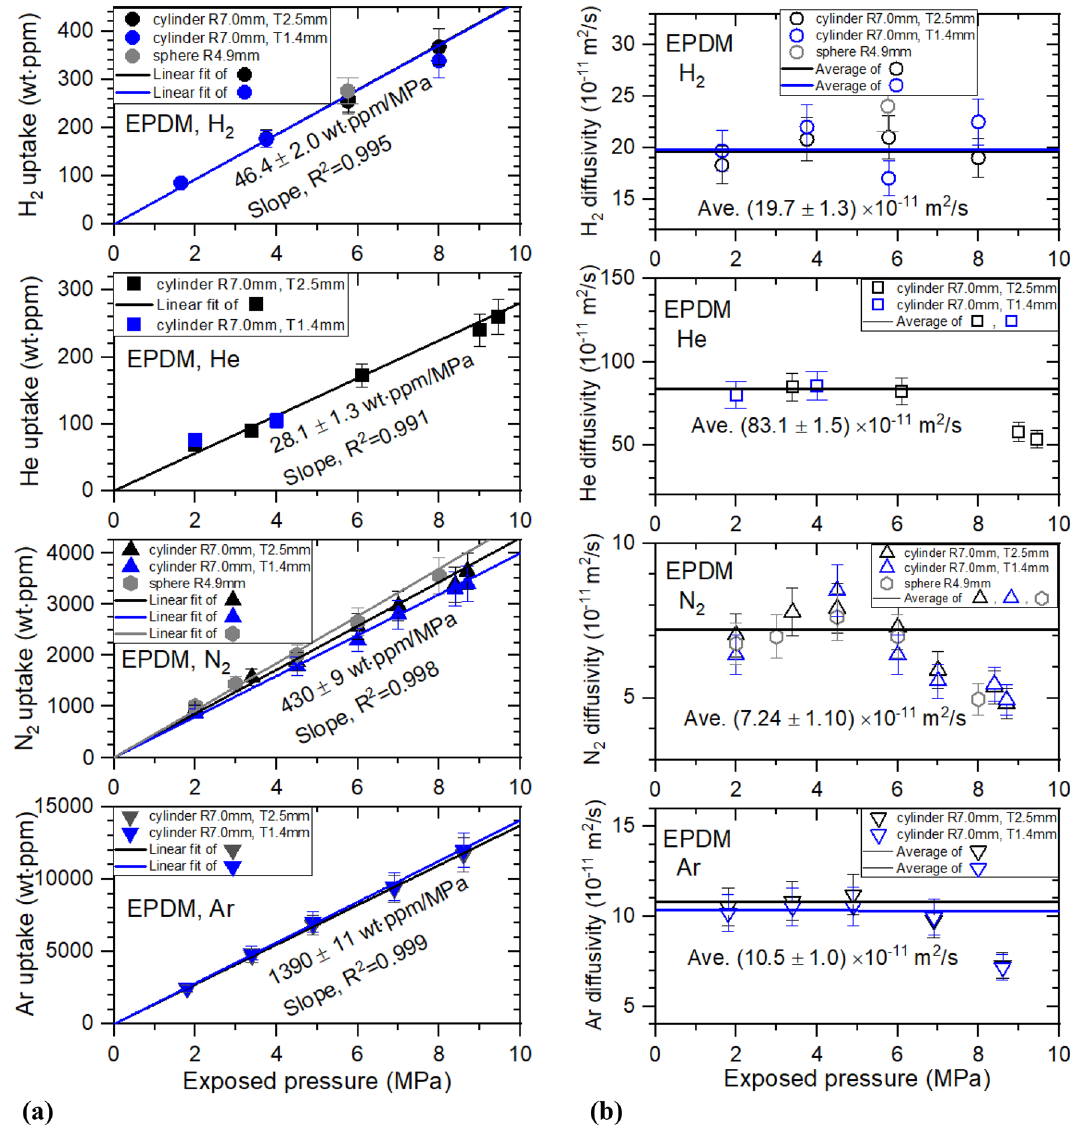
Figure 7. ( a ) Gas uptake ( C ) and ( b ) diffusivity ( D ) versus exposed pressure for four gases in cylindrical ∞ EPDM with different thicknesses and spherical EPDM. R indicates the radius of cylindrical and spherical EPDM. T indicates the thickness of cylindrical